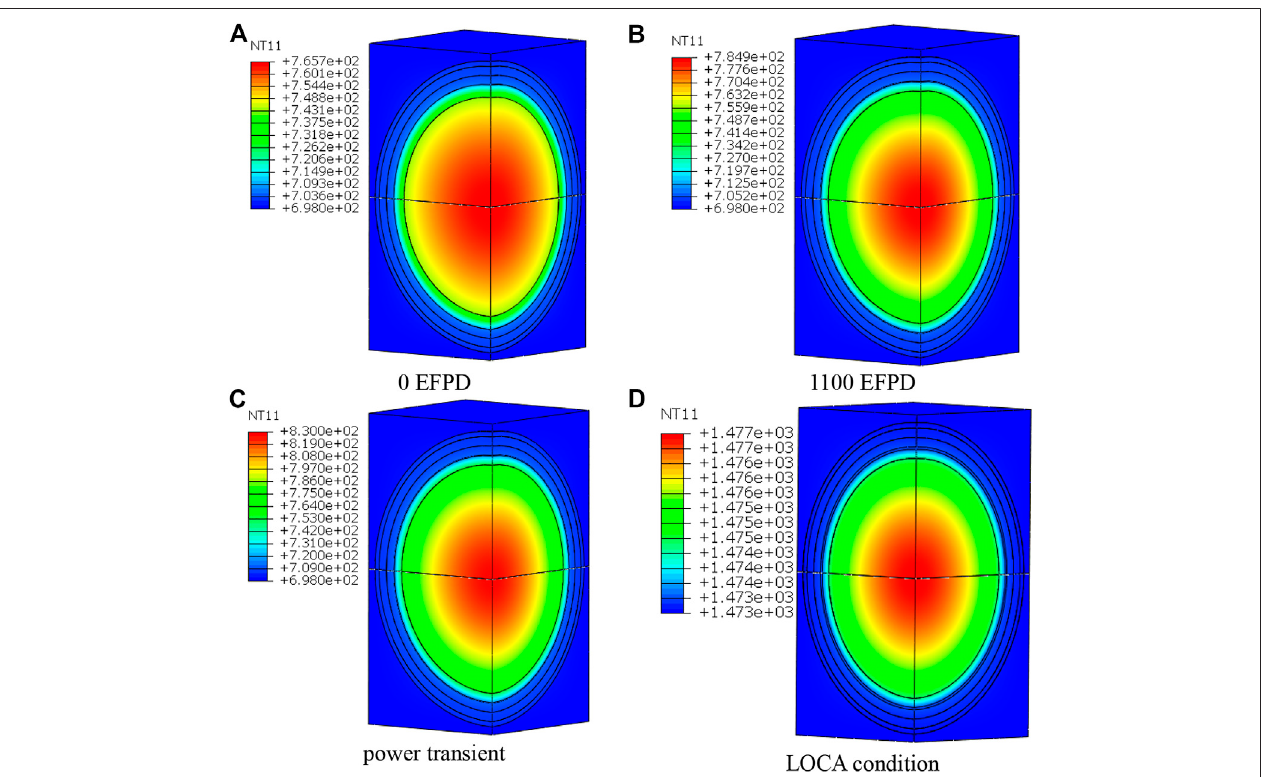
FIGURE 4 | Temperature distribution contour of FCM fuel RVE model under different conditions (EFPD, Effective Full Power Day). (A) 0 EFPD. (B) 1100 EFPD. (C) power transient. (D) LOCA condition.